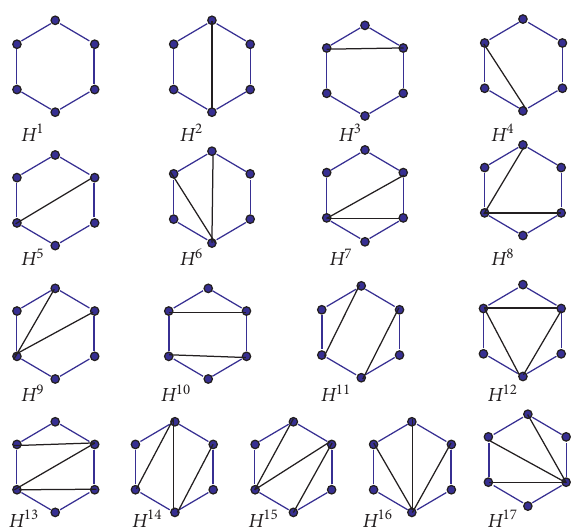
Figure 2: Hexagonal planar graphs with 2, 3, 4, and 5 faces.